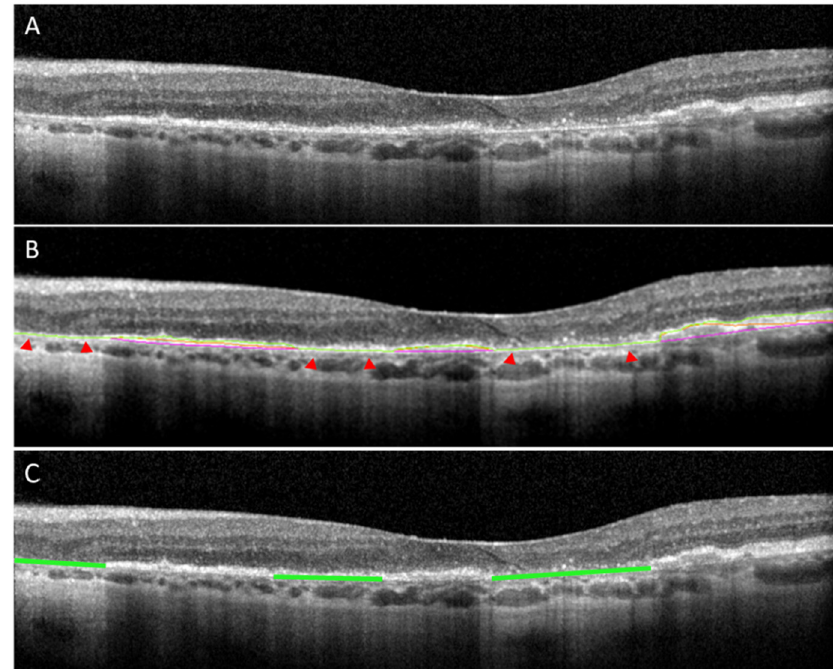
Figure 1. ( A ) Raw B-scan showing areas advanced atrophic changes; ( B ) Multi-layer segmented SD-OCT B-scan from a patient with GA with EZ denoted in green, RPE denoted in orange and BM denoted in pink. Red arrow heads indicate areas of concurrence of the three lines—definition of GA by initial read (i.e., absence of EZ and RPE); ( C ) Final GA ground truth mask overlay for the same B-scan indicated in green. SD-OCT: Spectral Domain Optical Coherence Tomography; GA: Geographic Atrophy; EZ: Ellipsoid Zone; RPE: Retinal Pigment Epithelium; BM: Bruchs Membrane. Image shown was Captured using Spectralis HRA+OCT (Heidelberg Engineering, Heidelberg, Germany) with the 97 B-scan macular cube